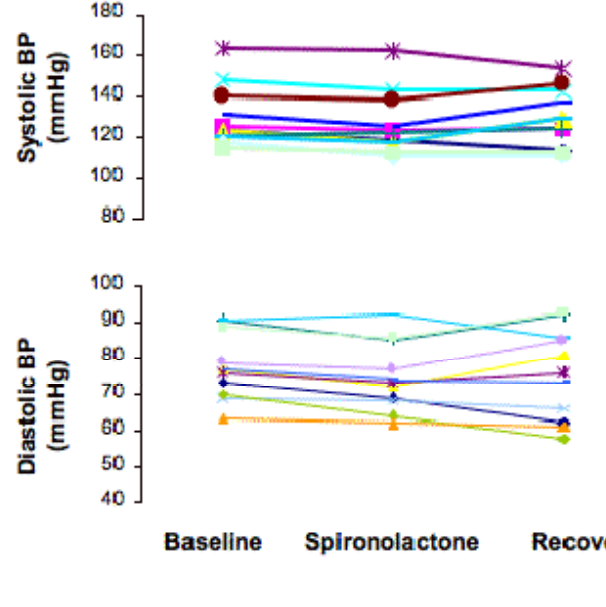
Figure 2. Systolic (upper panel) and diastolic (lower panel) blood pressure in each individual patient at baseline, and at the end of spironolactone treatment and of the recovery